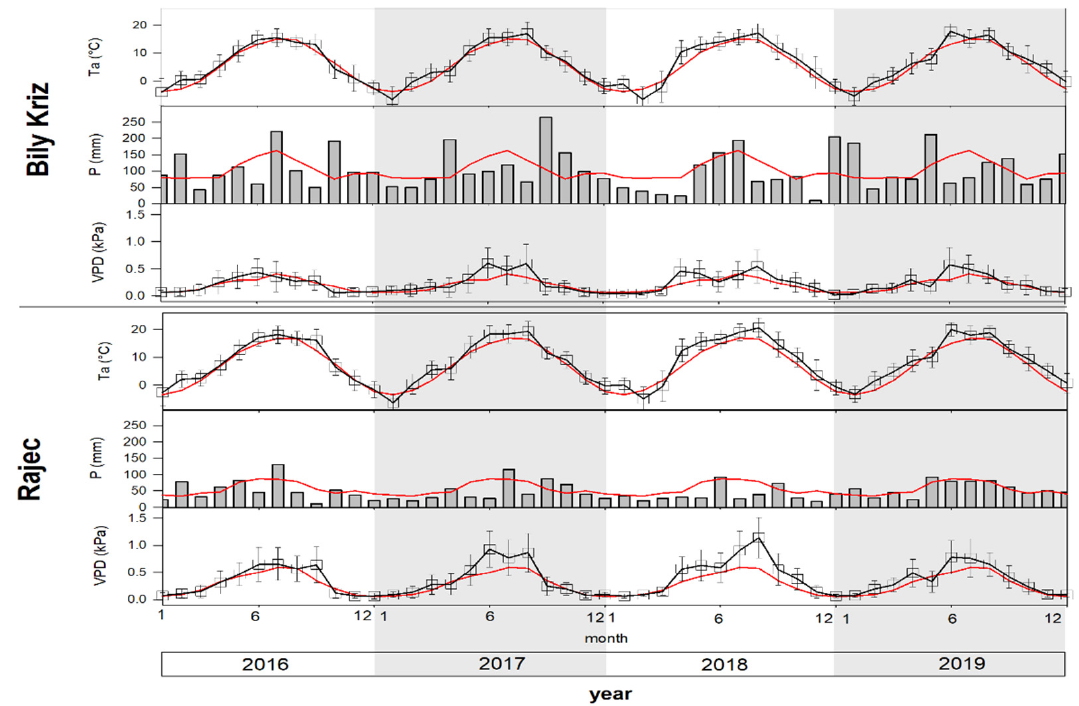
Figure 3. The seasonal course of monthly mean air temperature Ta ( ◦ C), monthly sum of precipitation P (mm) and monthly mean of vapor pressure deficit VPD (kPa) at the ESP Bily Kriz and Rajec in the years 2016–2019. Red lines represent long-term measurements (1961–2010). Vertical bars represent standard deviation.